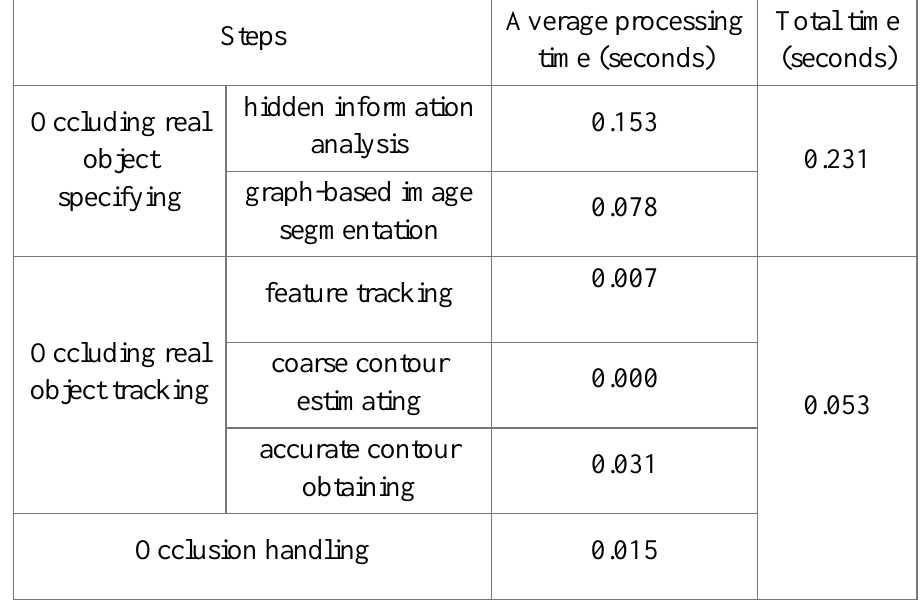
Table 1. Processing time of each